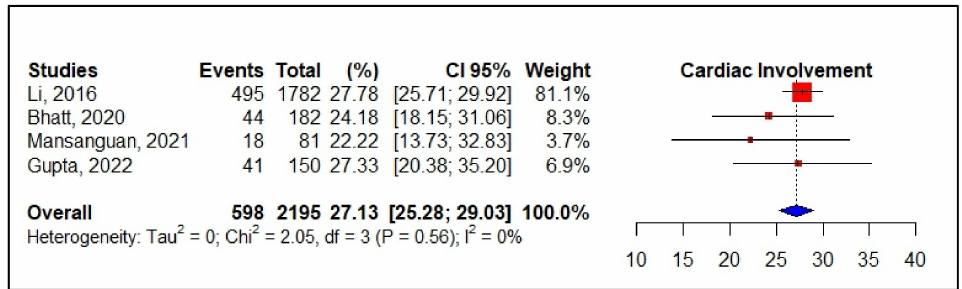
Figure 5. Forest plot of the frequency of cardiac events in dengue, using ESC criteria, 2013. Legend : CI—confidence interval; ESC—European Society of Cardiology.